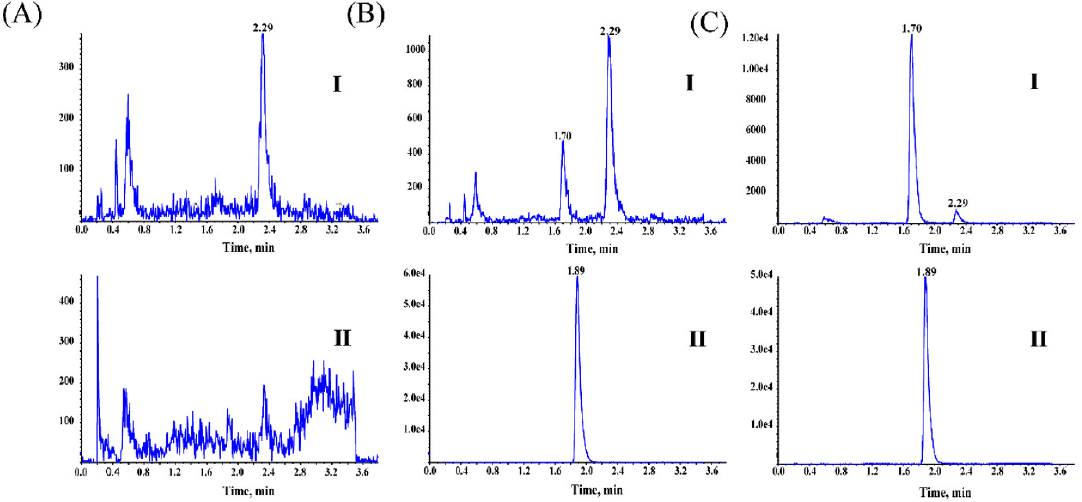
Figure 3. MRM chromatograms of physalin A and IS from rat plasma. ( A ) Blank rat plasma; ( B ) blank plasma samples spiked with physalin A (at LLOQ level) and IS; ( C ) real plasma samples obtained from a rat following administration of 32 mg/kg physalin A. I-Physalin A; II-IS.